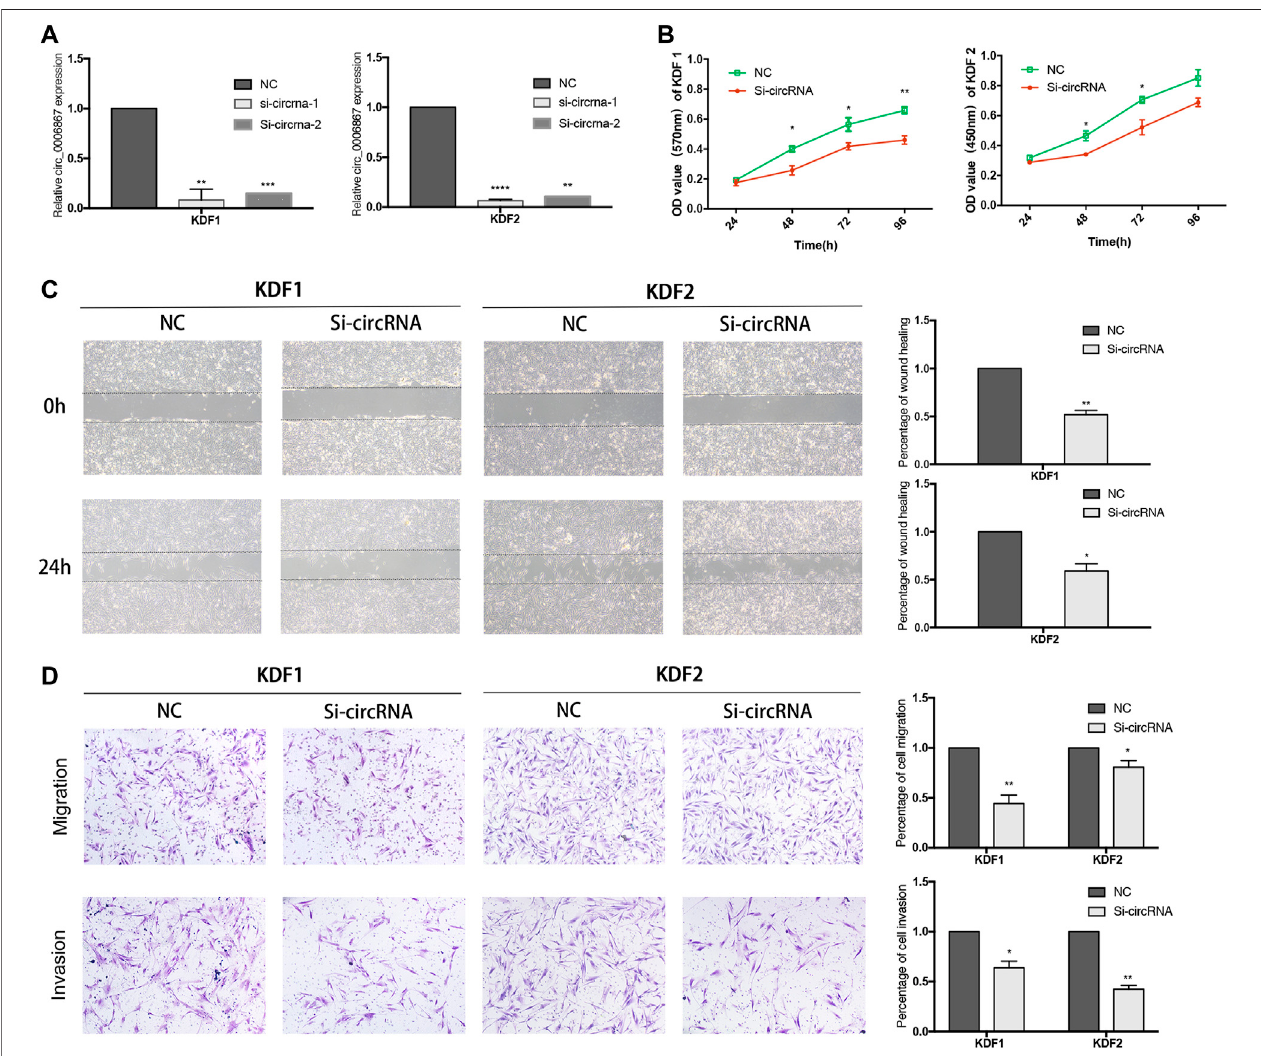
FIGURE7| Inhibitionofhsa_circ_0006867suppresseskeloidcellproliferation,migration,andinvasion. (A) EffectofsiRNAstargetinghsa_circ_0006867. (B) CCK- 8 assays. (C) Scratch wound-healing assays. (D) Transwell migration and invasion assays. *p < 0.05, **p < 0.01, and ***p < 0.001.